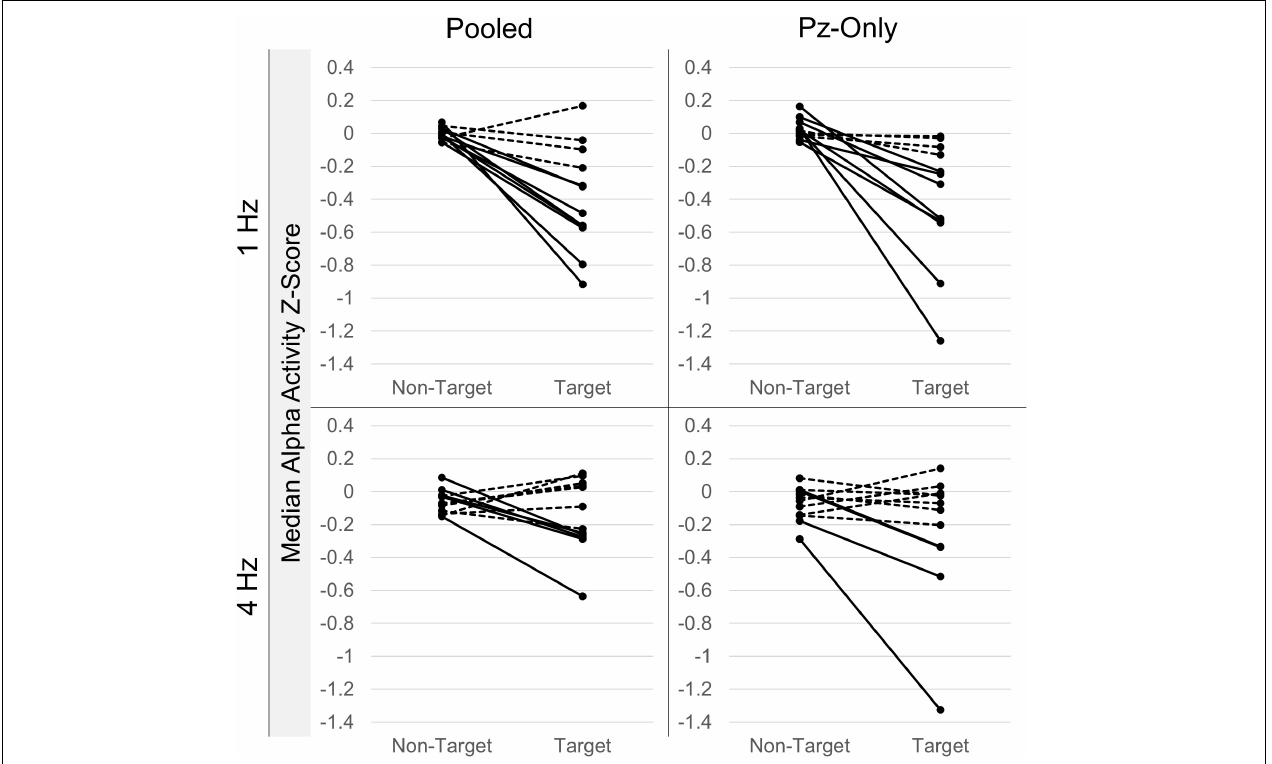
FIGURE 5 | Intra-individual alpha attenuation effects. Median target and non-target alpha activity Z-scores from individual RSVP calibrations. Data are sorted according to presentation rate and electrode source. Lines connect corresponding non-target and target estimates from within-individual recordings. Significant within-participant non-target/target median differences ( p < 0.05; Mann-Whitney U -tests) are denoted by solid lines; non-significant differences ( p > 0.05) are drawn as dashed lines. Plots show clear variability in the attenuation effect across individual participants and presentation conditions. Alpha attenuation effects appear to be greater at Pz for select individuals, but also more variable across